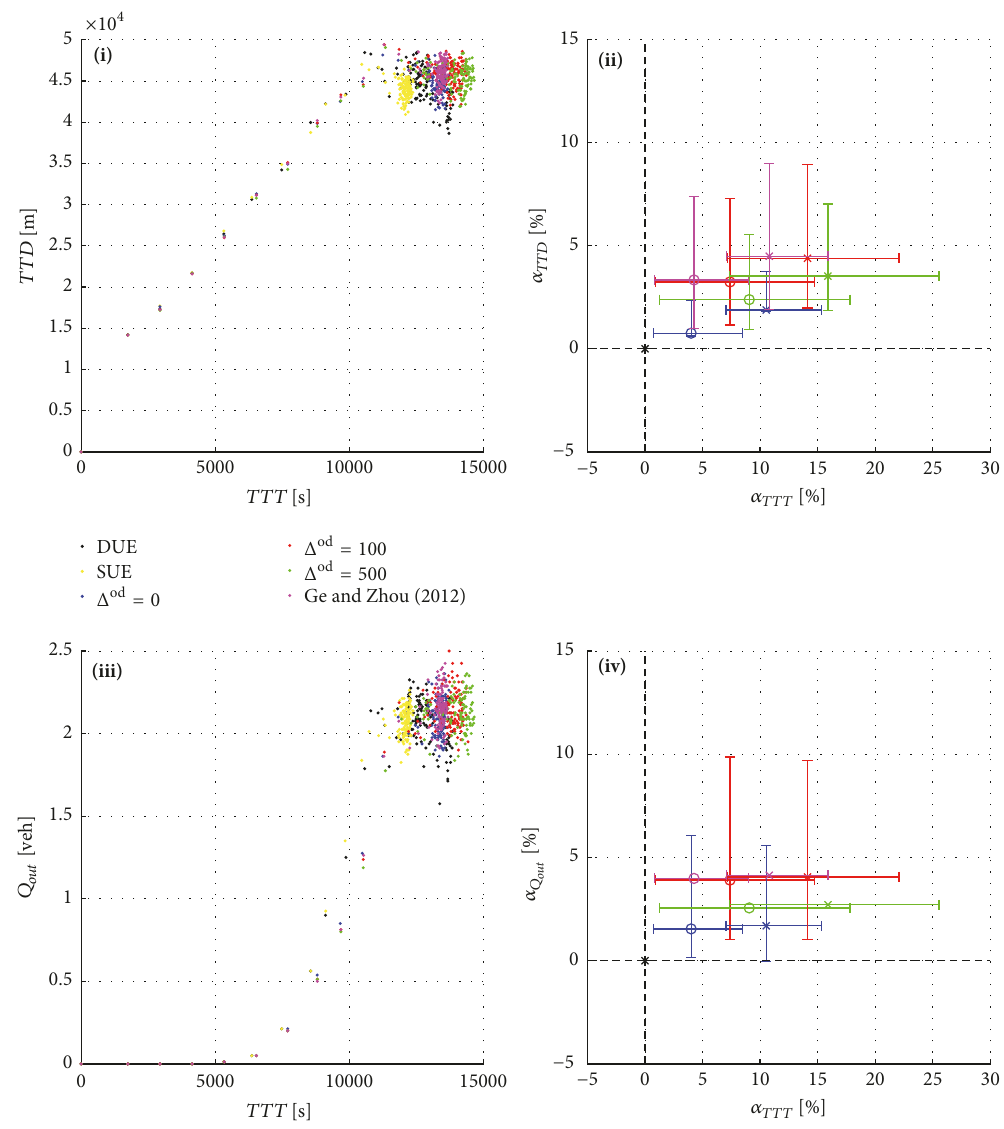
Figure 8: Same as in Figure 7, but for the strict preferences search